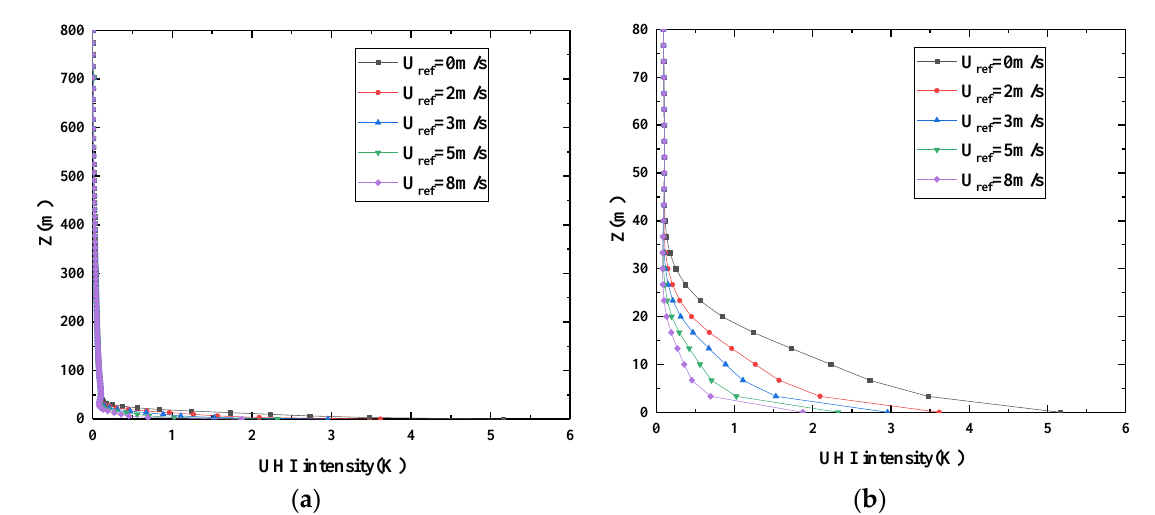
Figure 10. The vertical profiles of the UHI intensities at different ambient crosswinds in the plane x = −2500 m: ( a ) within the computational height and ( b ) at the urban canopy’s heights.